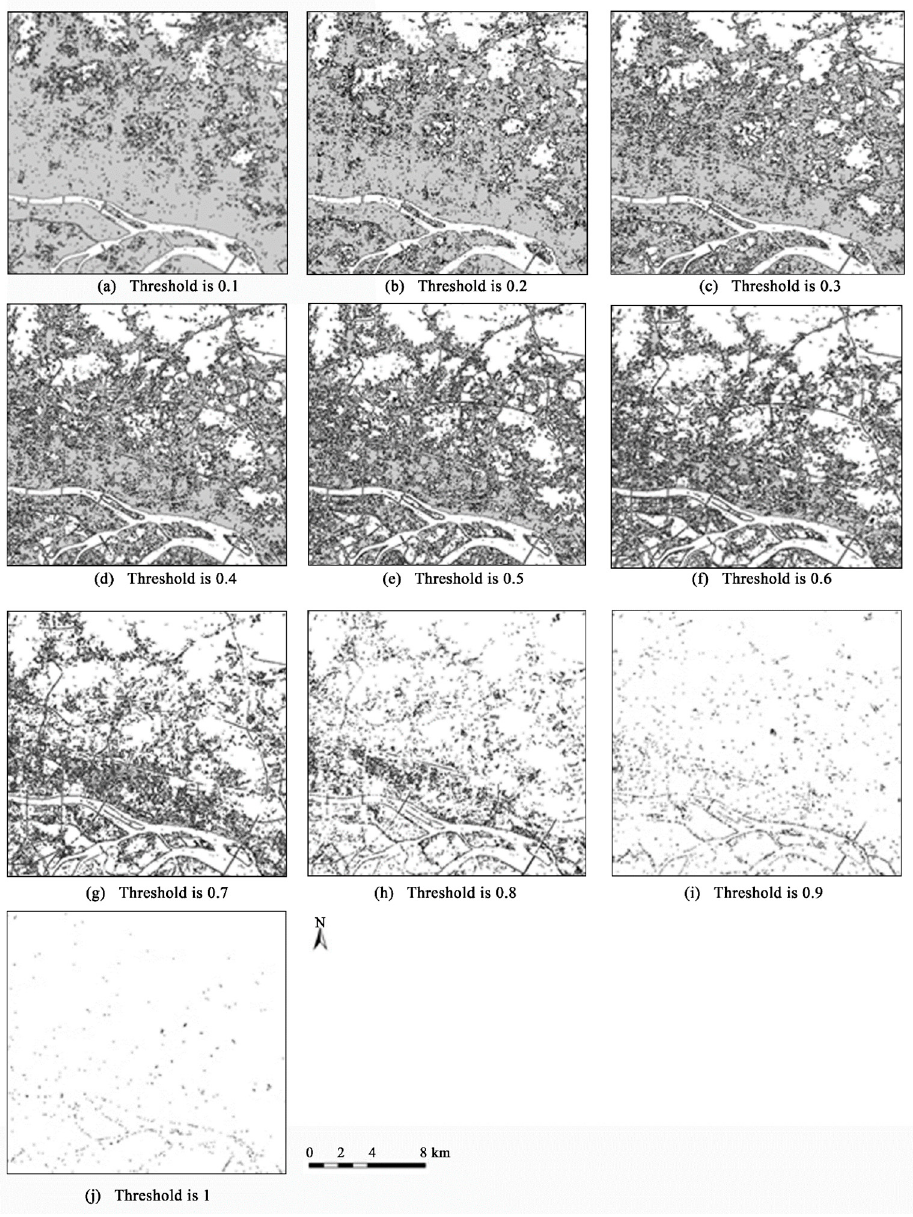
Figure 7. Scope for every threshold.